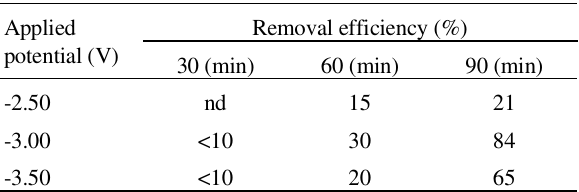
Table 2. Effect of applied potential and electrolysis time on the Cd 2+ ion